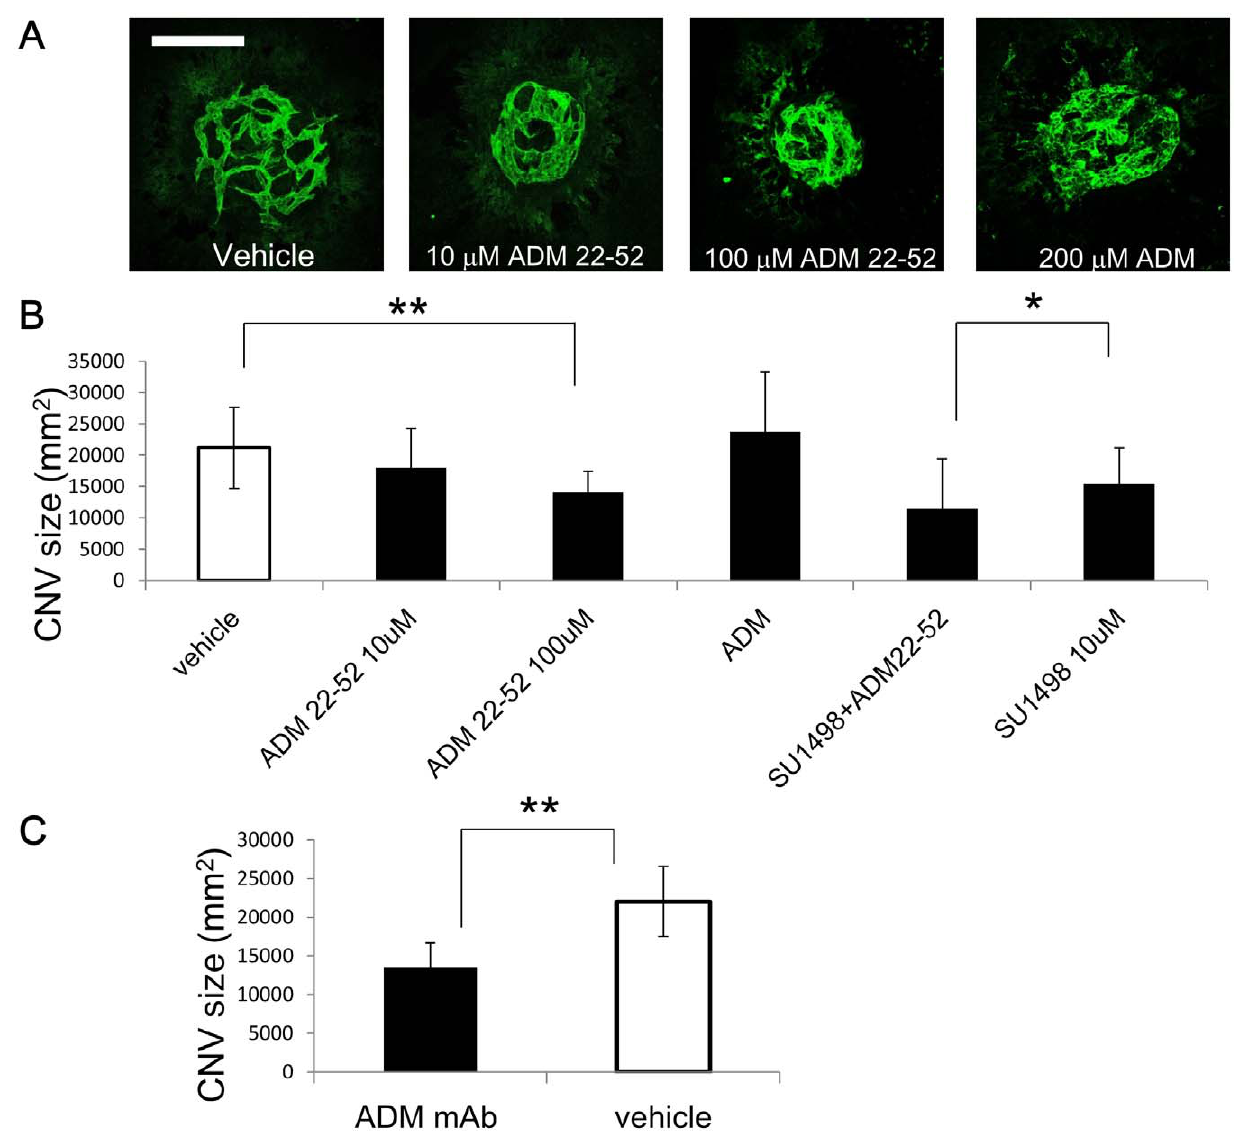
Figure 4. Suppression of CNV in mice by blocking ADM. (A) Flat-mount immunofluorescence staining with anti-PECAM-1/CD31 antibody in the choroid after vehicle, ADM (22–52) or recombinant ADM treatment. Scale bar: 100 m m. (B) Quantitative analysis of CNV size as revealed in (A). (n=16, **P , 0.01) and quantitative analysis of CNV size after treatment with 10 m M SU1498 with or without 100 m M ADM (22–52) (n=8, *P , 0.05). (C) Quantitative analysis of CNV size treated with ADM mAb compared to vehicle. (n=10, **P , 0.01). Error bars indicate mean 6